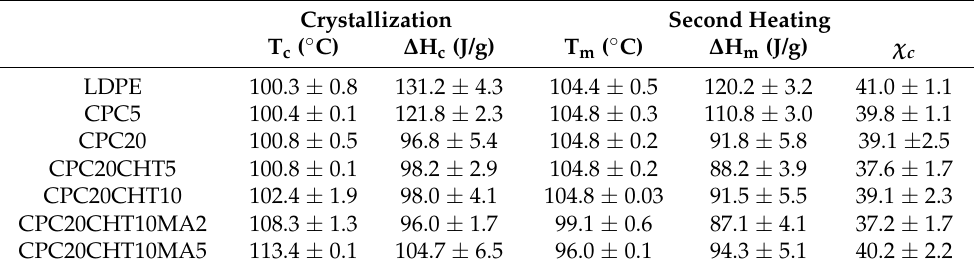
Figure 3. The representative DSC thermograms of CPC materials using a bio-based LDPE as a matrix on cork biocomposites: ( a ) second heating step and ( b ) first cooling step. Table 1. Melting temperatures and enthalpies, crystallization temperatures, and crystallinity degrees of CPCs with bio-based LDPE as the matrix.